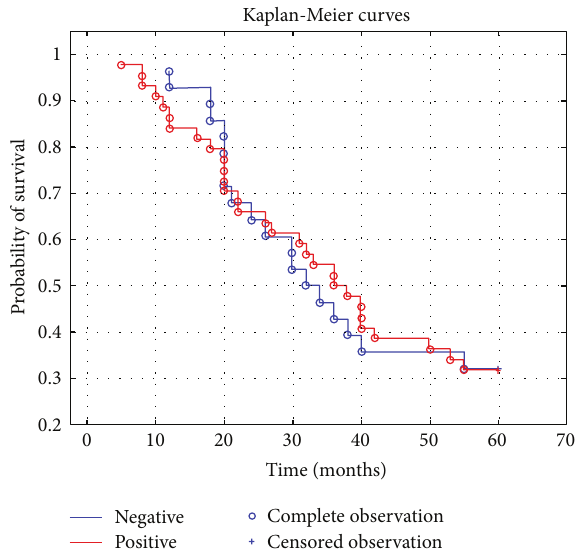
Figure 1: Survival curves in relation to AMH